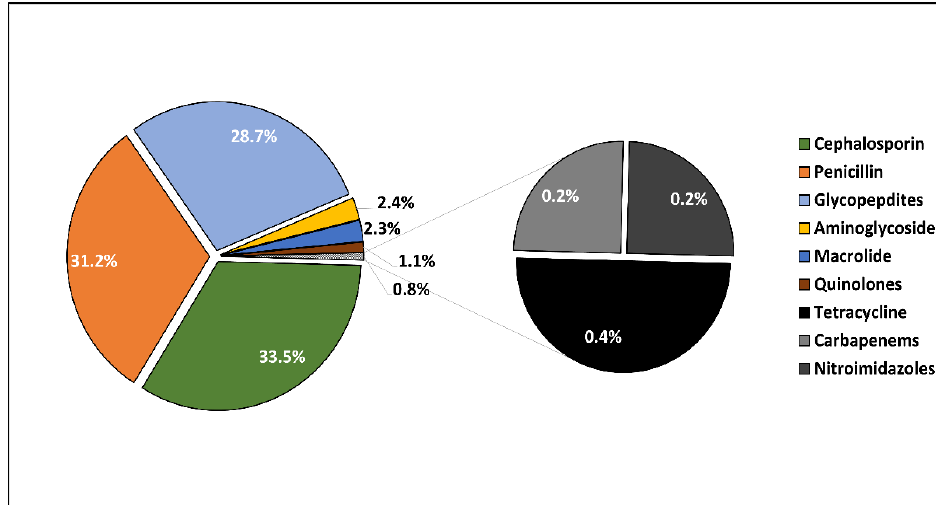
Figure 1. Distribution of antibiotics used for patients with endocarditis. Data are represented as a pie chart of the nine antibiotic classes used in the affected patients in descending order of frequency of use.